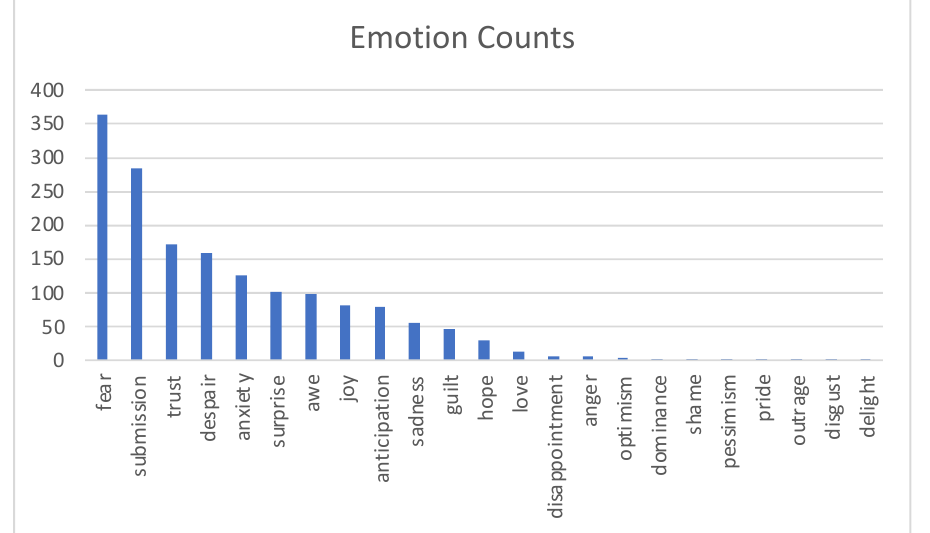
Figure 2. 23 emotions (fear, submission, trust, despair, anxiety, surprise, awe, joy, anticipation, sadness).